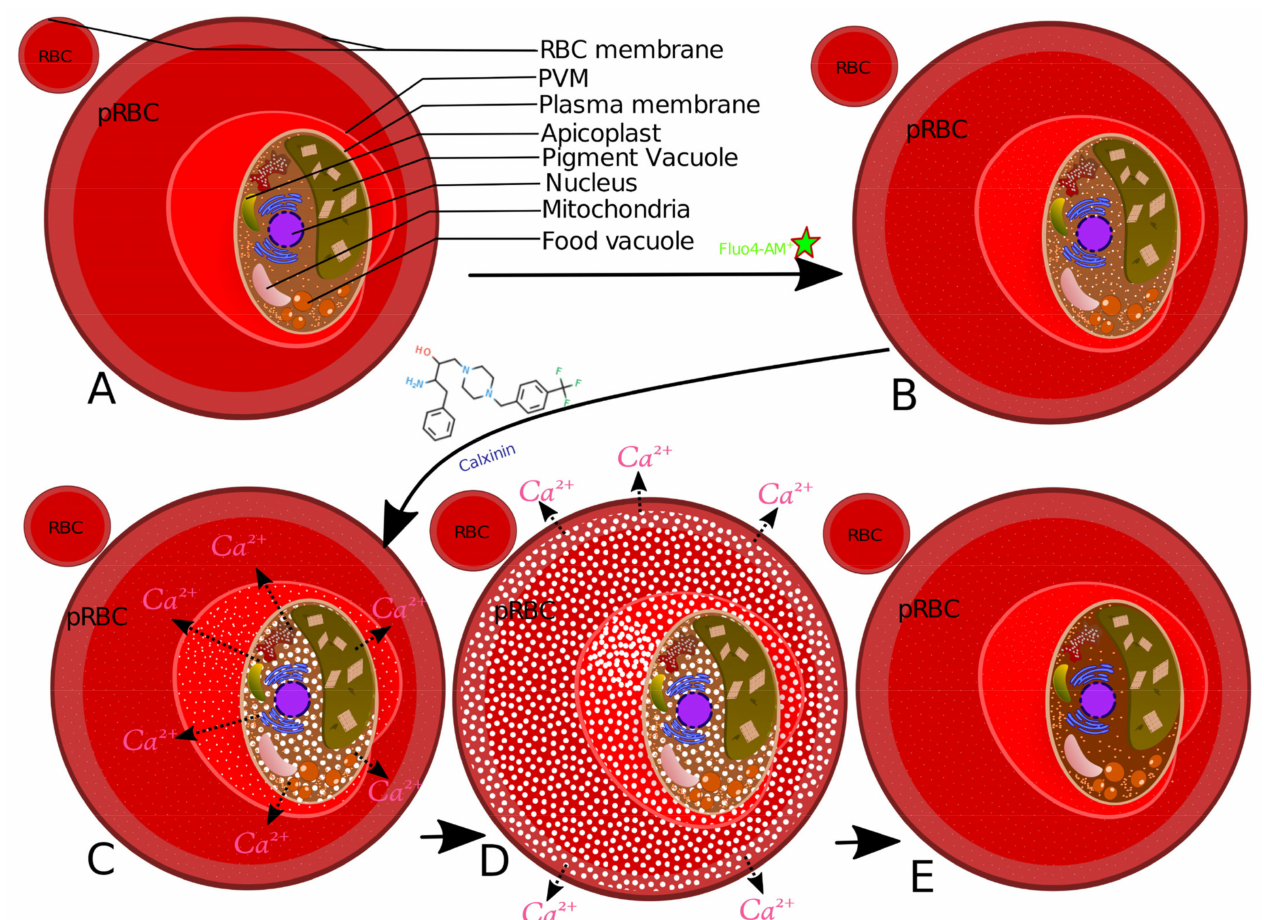
Figure 7. Schematic cartoon (not to scale) illustrating the observed mechanism of action of Calxinin in parasitized RBC (pRBC). Events are depicted based on both live fluorescent imaging and electron microscopy. ( A ) Two red blood cells: One is uninfected (left) and the other is a pRBC (right). The pRBC has a parasitophorous vacuolar membrane (PVM) and a trophozoite stage parasite. ( B ) An RBC is being loaded or “charged” with Fluo4-AM. The parasite, having high calcium content, fluoresces much more than the hypo-calcinated healthy and young RBCs (Figure 5A–C). Additionally, pRBCs inherently have a higher calcium level compared to RBCs. ( C ) After the addition of Calxinin, there is an initial Ca 2+ surge within the parasite cytoplasm suggesting an organelle as the source of Ca 2+ (Figure 5K). ( D ) The second phase of the Ca 2+ surge causes the whole RBC to fluoresce brightly due to saturation of parasite cytoplasm and leaking of Ca 2+ to the pRBC cytoplasm. ( E ) The surge or “spike” in pRBC Ca 2+ rapidly comes down, while the intra-parasite Ca 2+ level remains saturated due to continued activation by Calxinin. Total parasite Ca 2+ normalizes over time due to the irreversible loss of Ca 2+ (Figure